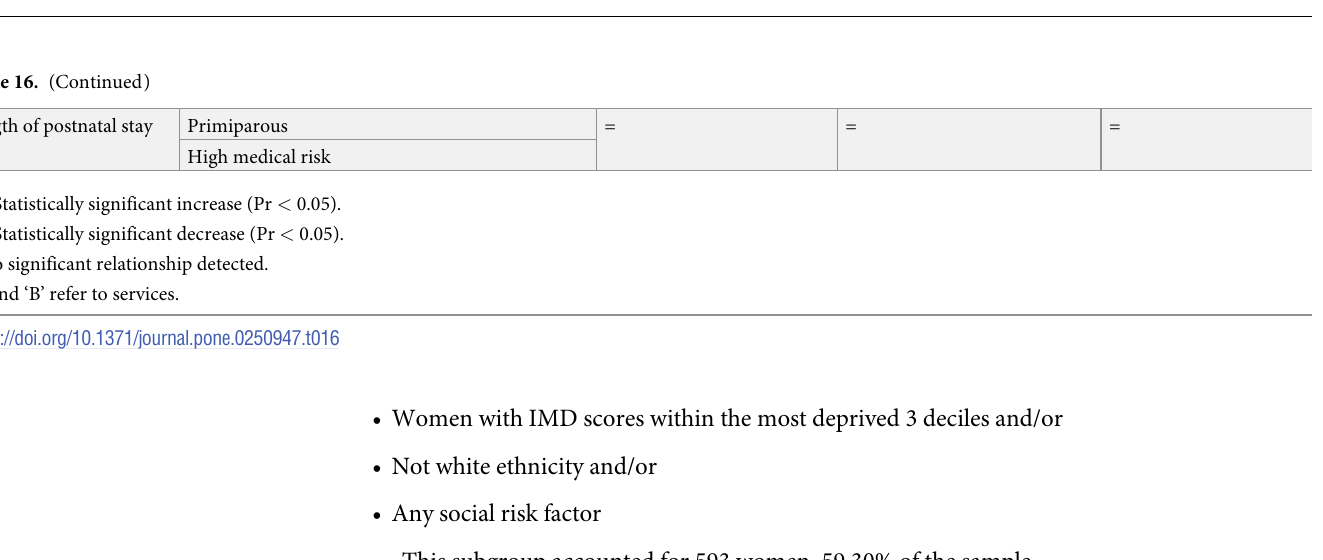
Table 17. Subgroup analysis by model of care received. Outcome